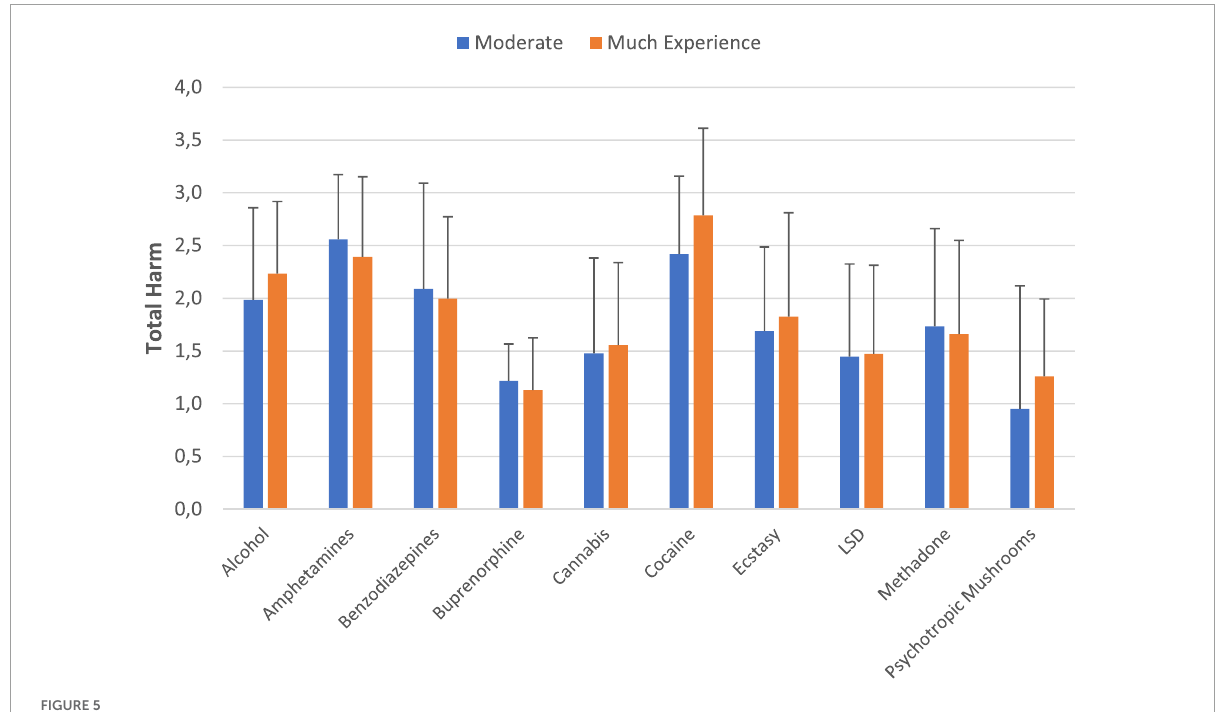
FIGURE5 Substance harm-assessments and level of the users’ experience with the corresponding substances. Displayed are substances with n > 5 assessments in each experience group. * p < 0.01. The underlying data are shown in Supplementary Table 1 .